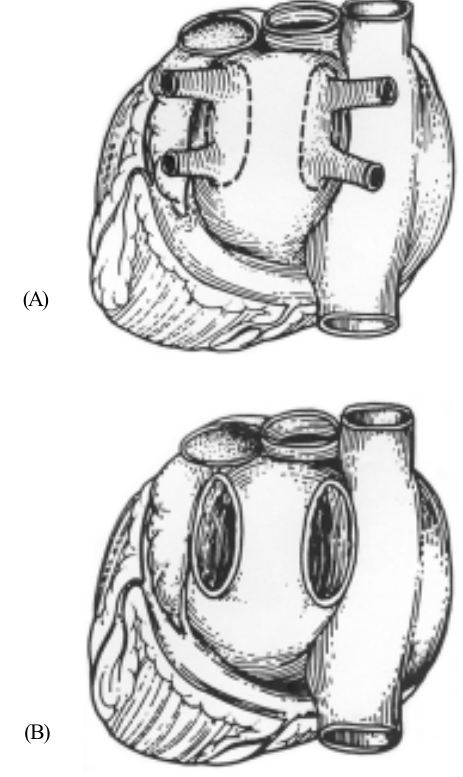
Fig. 1 - (A) Harvested donor heart with the stumps of the pulmonary veins [9]. (B) Double-lung/bicaval implantation with two openings, embodying the right and left pulmonary arteries